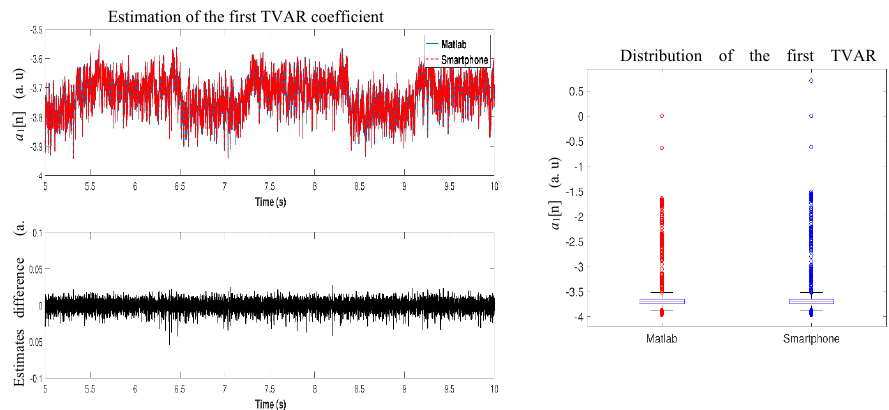
Figure 8. Example of RLS-TVAR coefficients estimates using the implemented mobile app. Top : Time waveform of an inspiratory sound with inserted fine crackles at the end portion. Bottom : Time course of the RLS-TVAR coefficients estimated in the app.